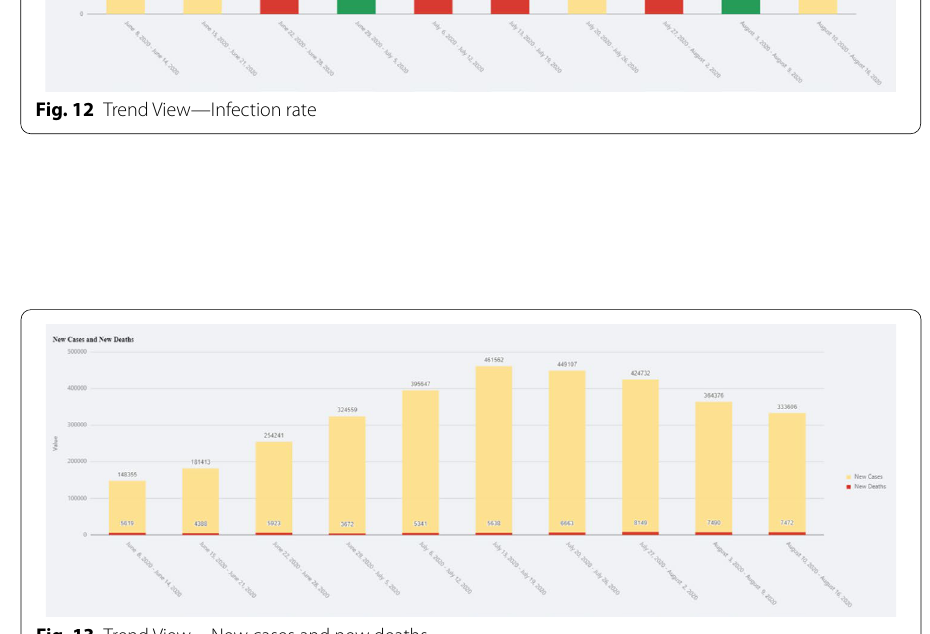
Fig. 13 Trend View—New cases and new